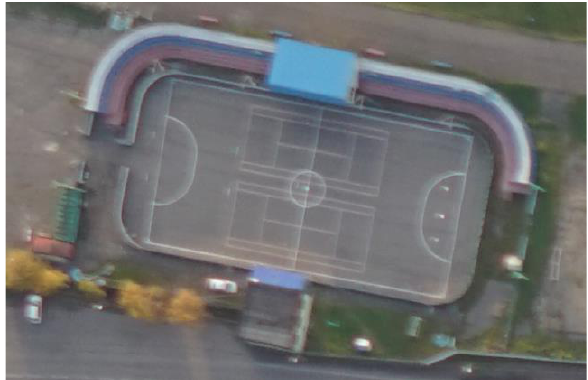
Figure 4. An example of double vision of edges and objects geometry distortion caused by motion blur Methods of blur assessment: visually based on sharp edges at high magnification, numerically with formula for the normalized length of the edge transition l norm